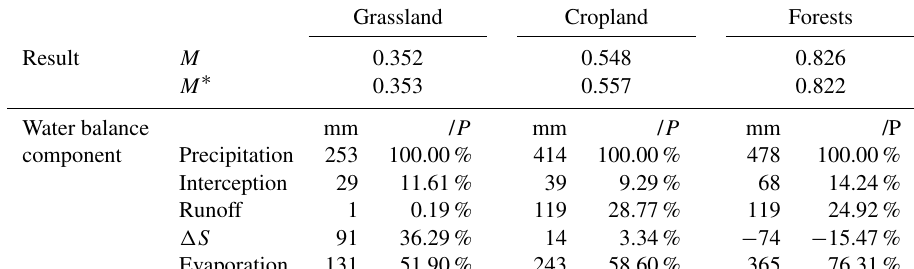
Table 2. Water balance components of different land cover types.